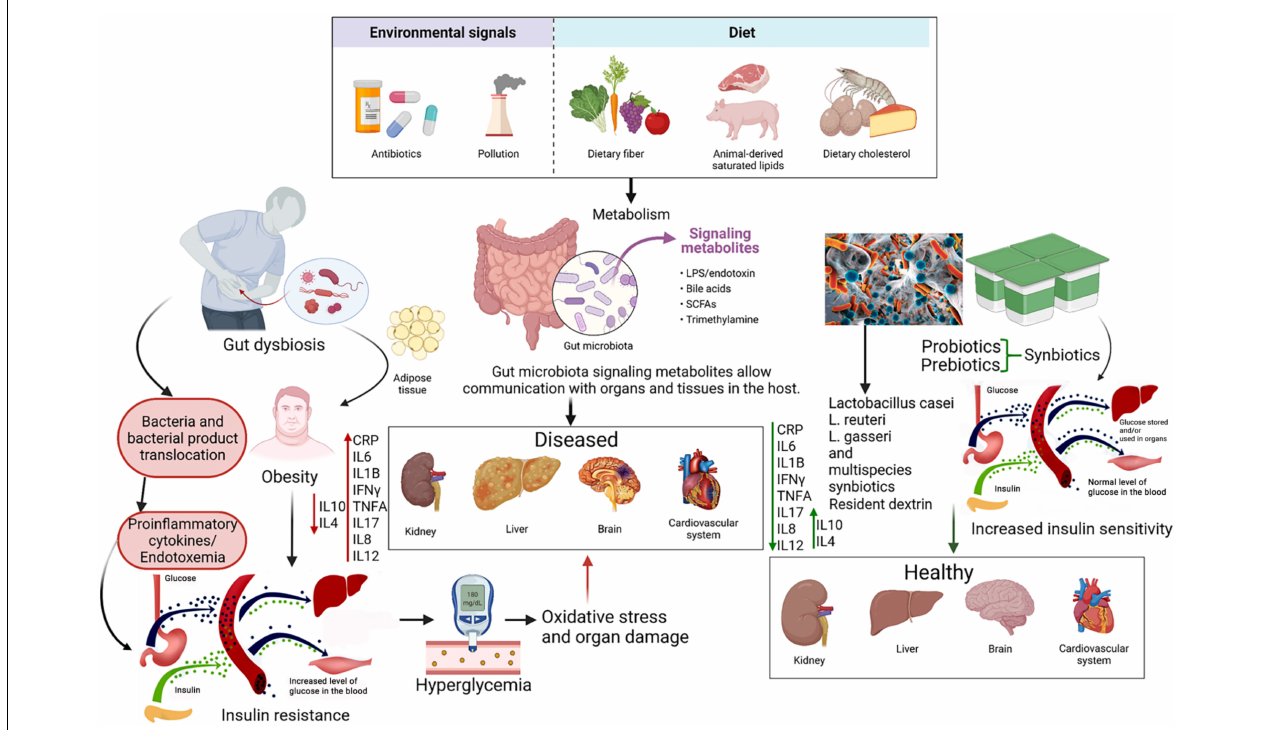
FIGURE 2 | Summary diagram illustrating the effect of diet, pre and probiotics as a potential safe therapy in treating